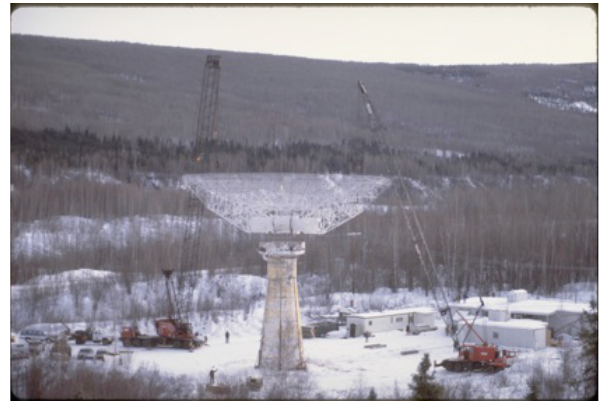
Figure 4. The removal of the reflector and torque tube from the gun mount, preparatory for shipping the system to Greenland. Photo by C.